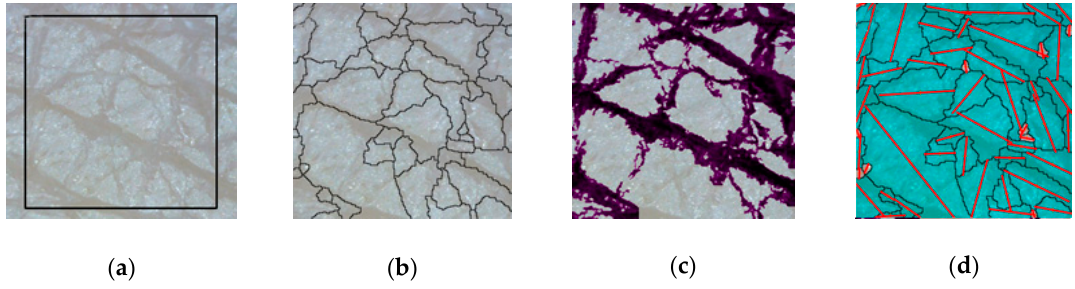
Figure 2. Examples of skin texture extraction step—( a ) original image with ROI; ( b ) wrinkle and cell detection; ( c ) recovered wrinkle width; ( d ) wrinkle cell gradients.